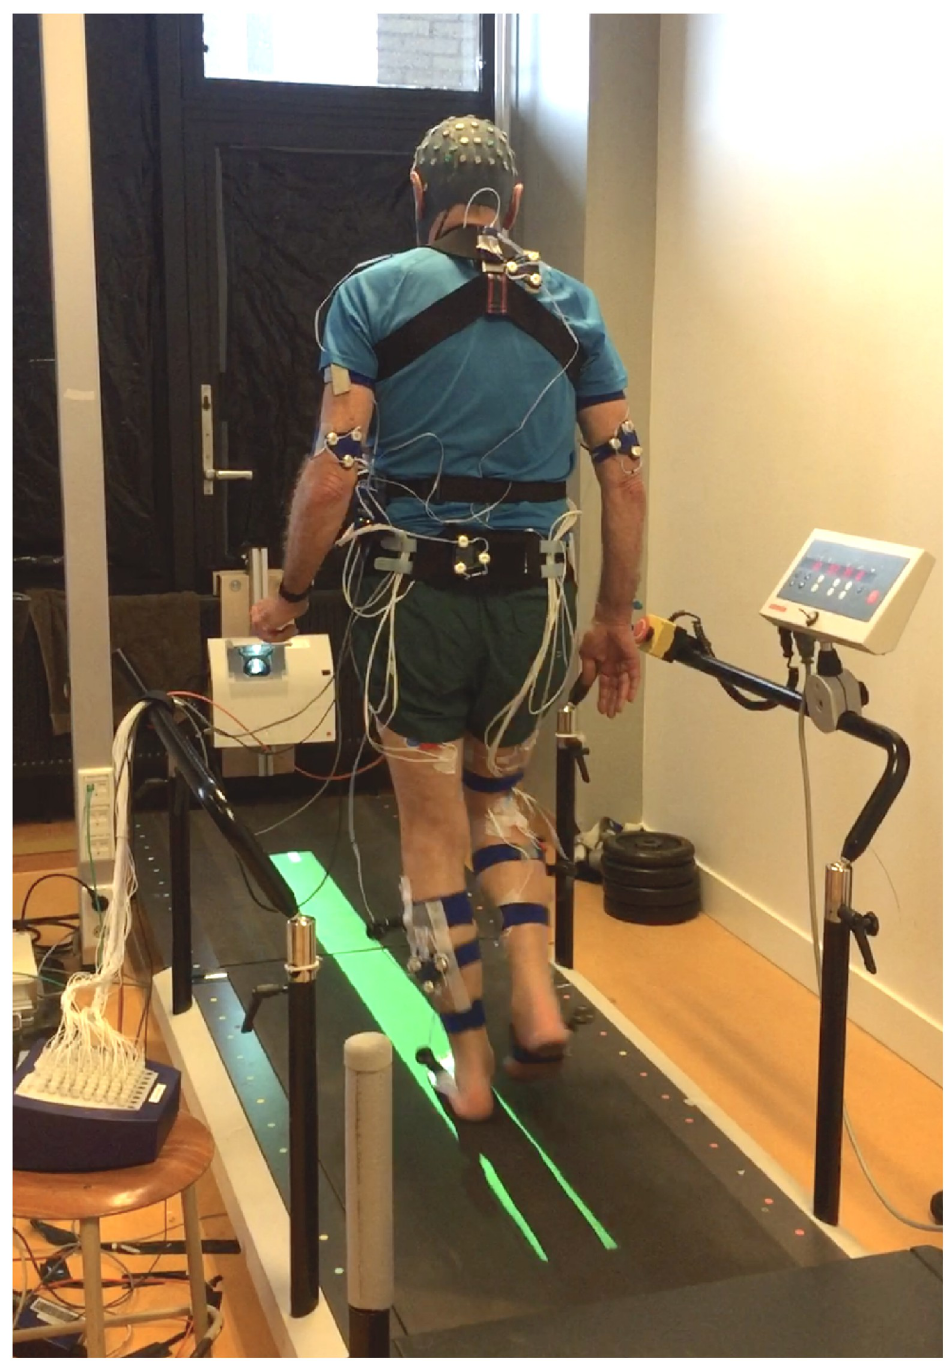
Fig 2. Narrow-base walking on a